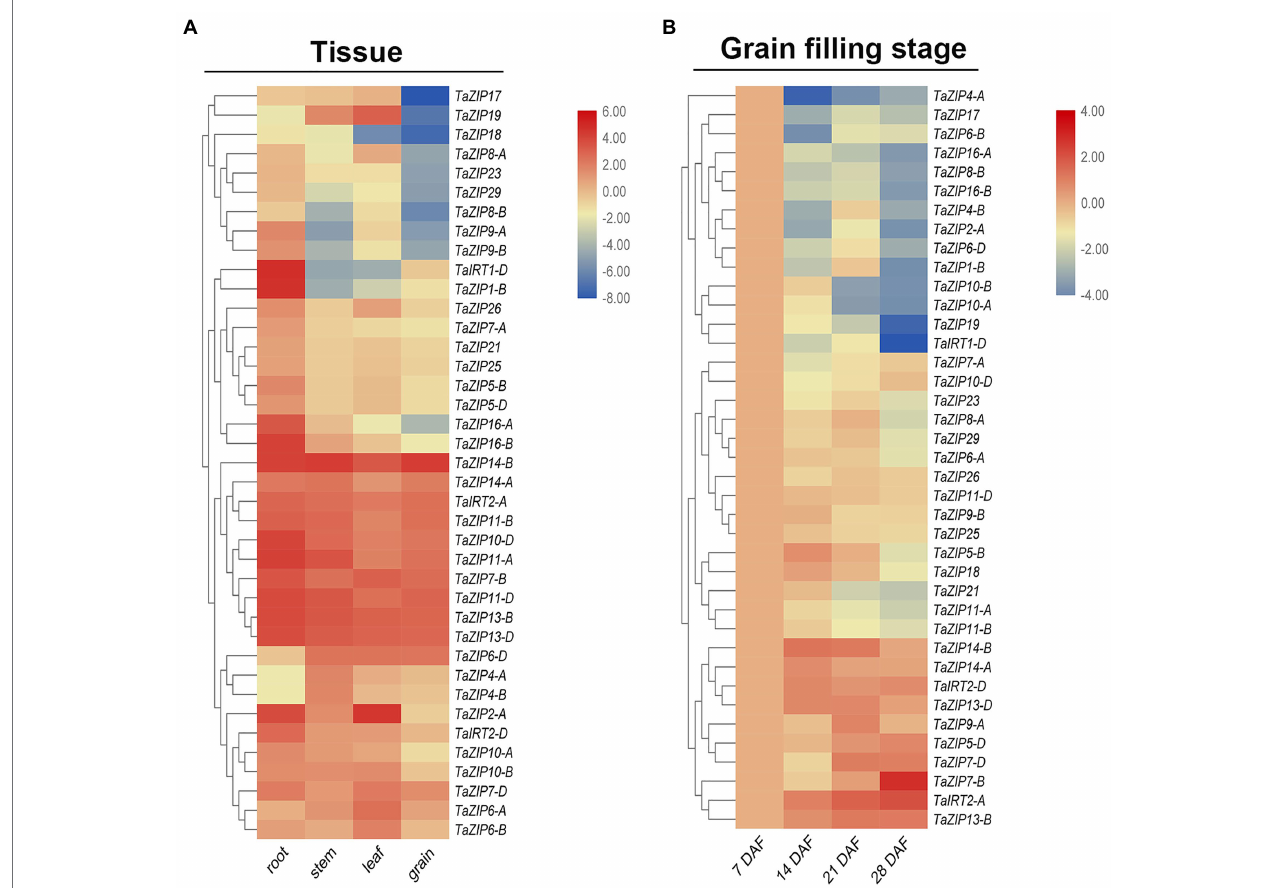
FIGURE 4 | Expression profiles of TaZIP genes in different tissues (A) and at different grain filling stages (B) . (A) RNA-seq data of roots, leaves, stems, and grains of the genotype Chinese Spring were download for the URGI database and used for expression profiles analysis. The expression level was determined by the fragments per kilobase per million (FPKM) calculated by StringTie v2.1.2 tool and log2 transformation was used for normalization. (B) The grain of genotype ZhongMai175 at different grain filling stages were collected and then used for qRT-PCR. The expression level was calculated according to the 2 −∆∆ C t method. Relative mRNA abundance of each gene was normalized with TaActin gene. DAF means day after flowering. The error bars indicate standard deviations. Three genes highlighted in yellow were used for cloned for downstream